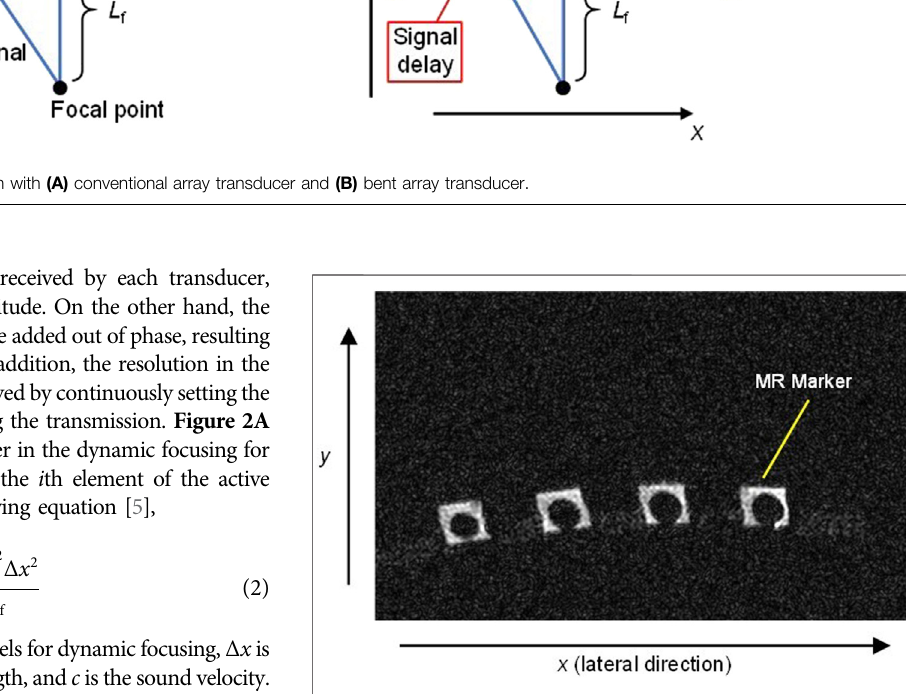
FIGURE 3| MR image ofthe cross section including the MR marker row of the ultrasonic probe that was obtained using 1.5 T